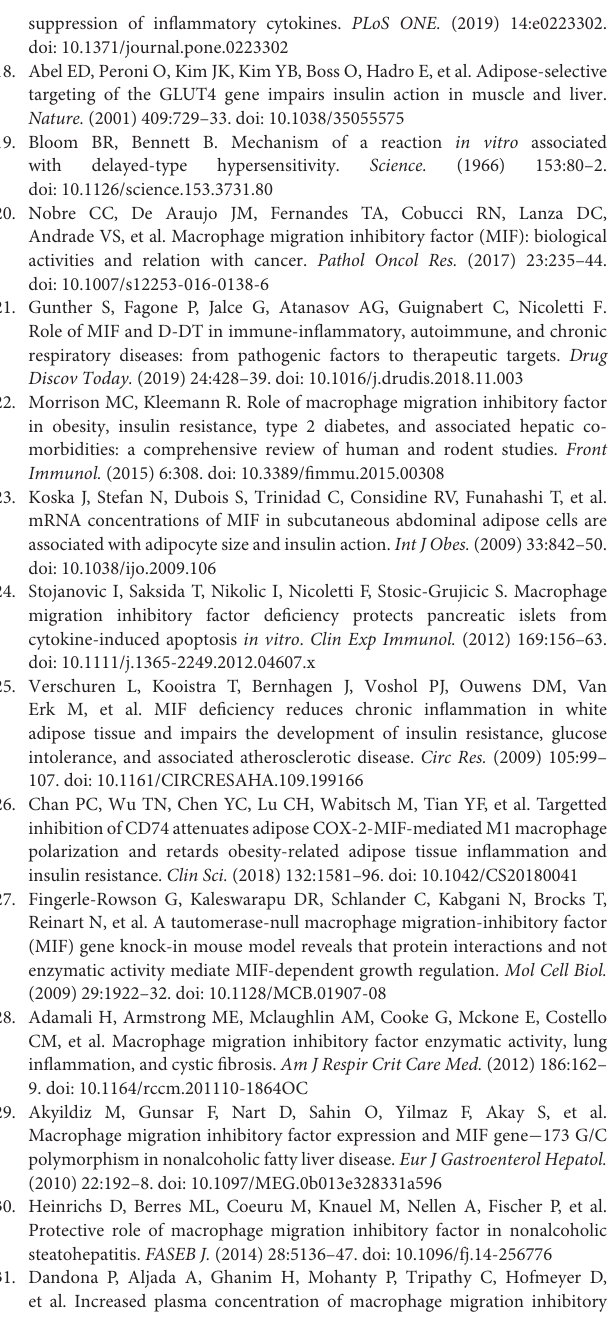
related genes mRNA expression. (E) The expressions of adipose tissue browning related genes mRNA expression. Data are shown as mean ± SEM, ∗ p < 0.05. n = 4–6 per group. Figure S2 | MIF P1G / P1G mice reduced WAT apoptosis and the weight of perirenal fat, epididymal fat, and liver tissue under HFD. (A) Immunohistochemical analysis of cleaved-Caspase-3 staining in WAT. (B) The weight of perirenal fat, epididymal fat, and subcutaneous fat. (C) The expression of PPAR α in muscle between two groups under ND and HFD. (D) The weight of liver tissue between two groups under HFD. Data are shown as mean ± SEM, ∗ p < 0.05, n = 5 per